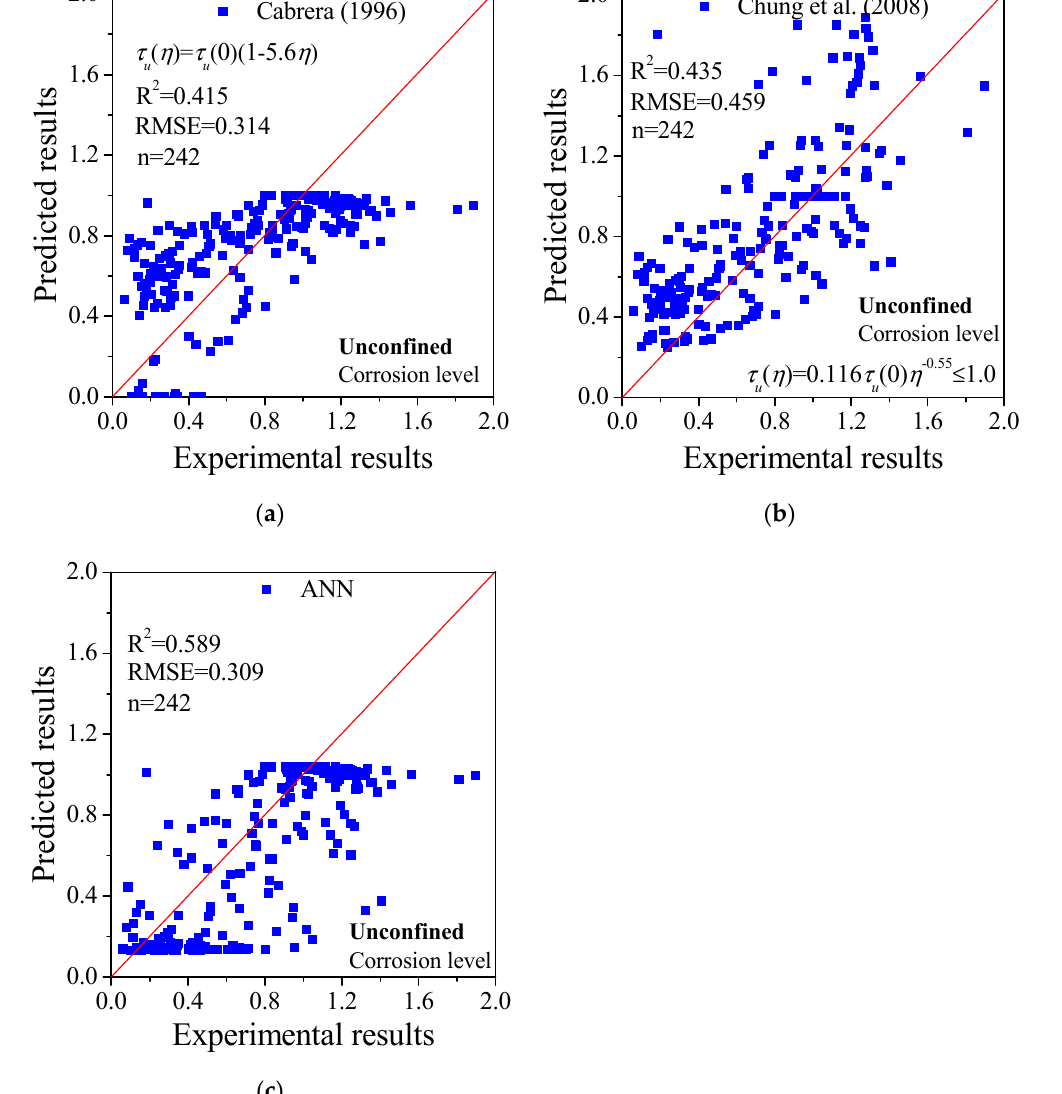
Figure 5. Comparison between the existing analytical models and ANN method considering only corrosion level as an input for specimens without stirrups (unconfined) (note: τ u ( η ) is the bond strength of specimen with corrosion level of η , τ u (0) is the bond strength of the specimen without corrosion damage and η is the corrosion level): ( a ) Cabrera (1996) [51]; ( b ) Chung et al. (2008) [52]; ( c ) ANN.